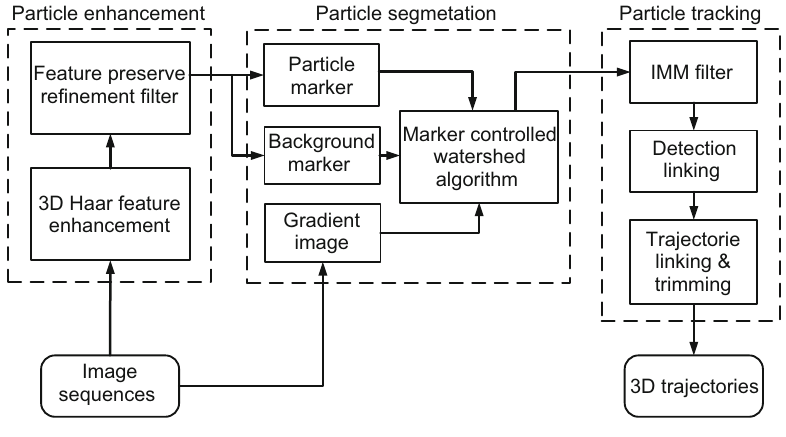
Figure 6. A fl ow chart to illustrate detailed processes of the MiTracker algorithm. There are three major components: the particle enhancement, the particle segmentation and the particle tracking. The algorithm details are described in the MATERIALS AND METHODS section about tracking mitochondria in 3-D image